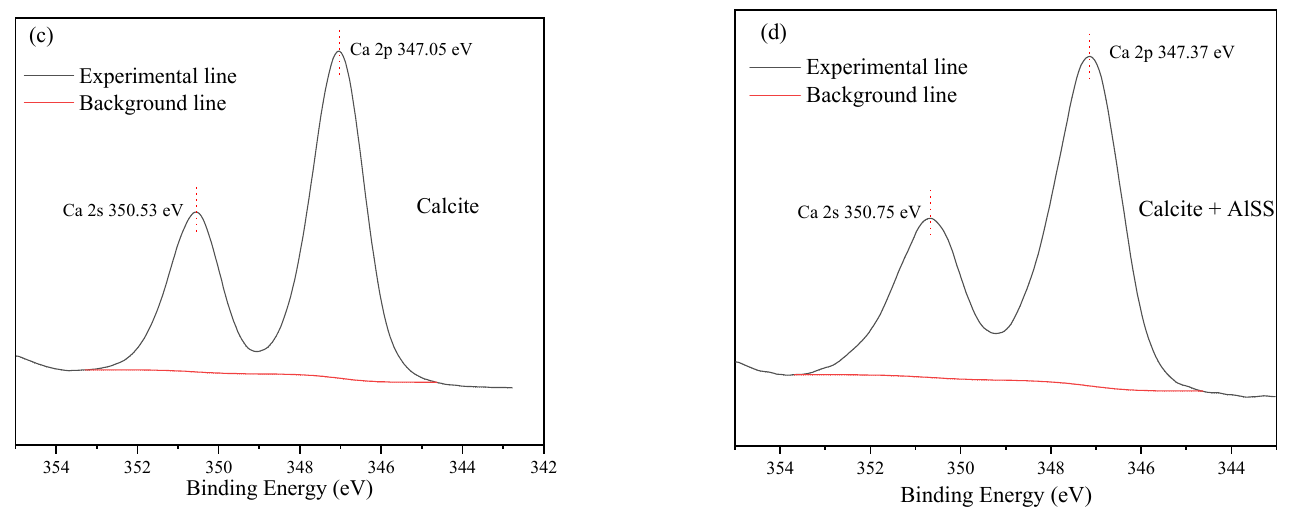
Figure 14. Sn and Ca XPS analysis of cassiterite ( a,b ) and calcite ( c,d ) before and after AlSS treatment.